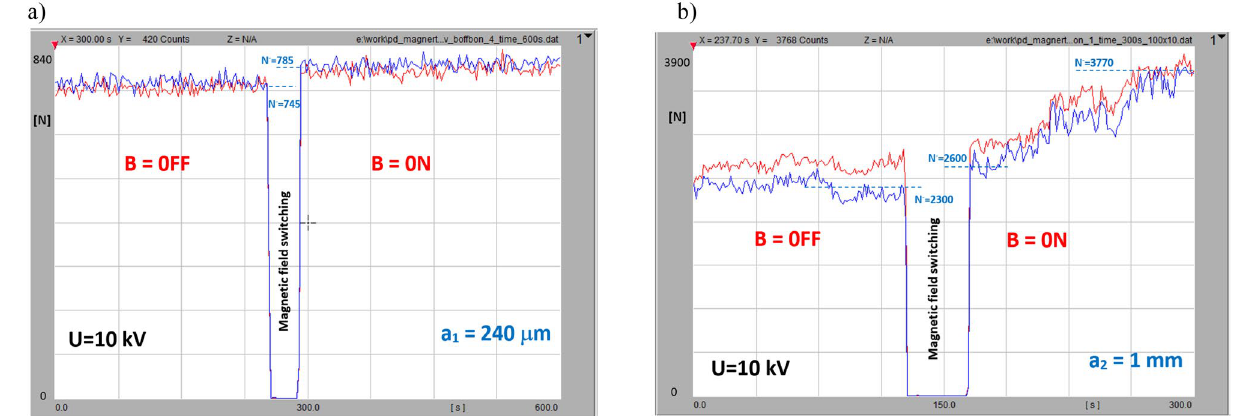
Figure 10. Time sequence B = off/B = on of impact of magnetic field on PD intensity in PE void at 10 kV with following thicknesses: ( a ) a 1 = 240 μm; ( b ) a 2 = 1 mm. The number N of negative and positive PD pulses is denoted in red and blue,